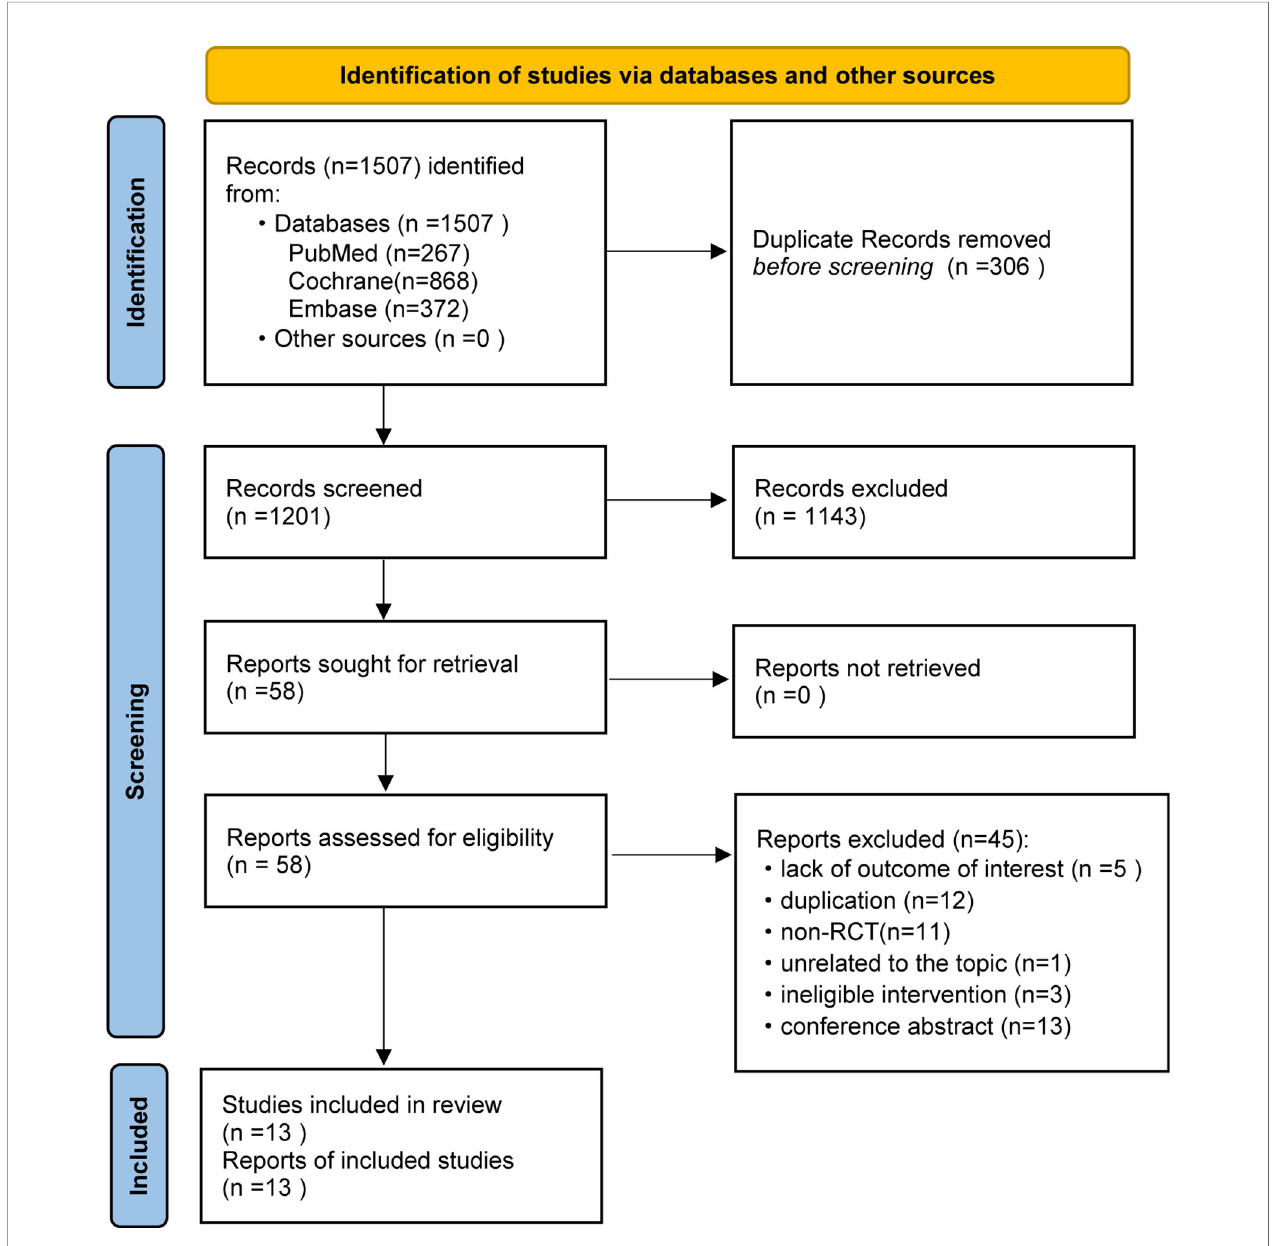
FIGURE 1 | Preferred Reporting Items for Systematic Reviews and Meta-Analyses (PRISMA) fl ow diagram of retrieval and selection of